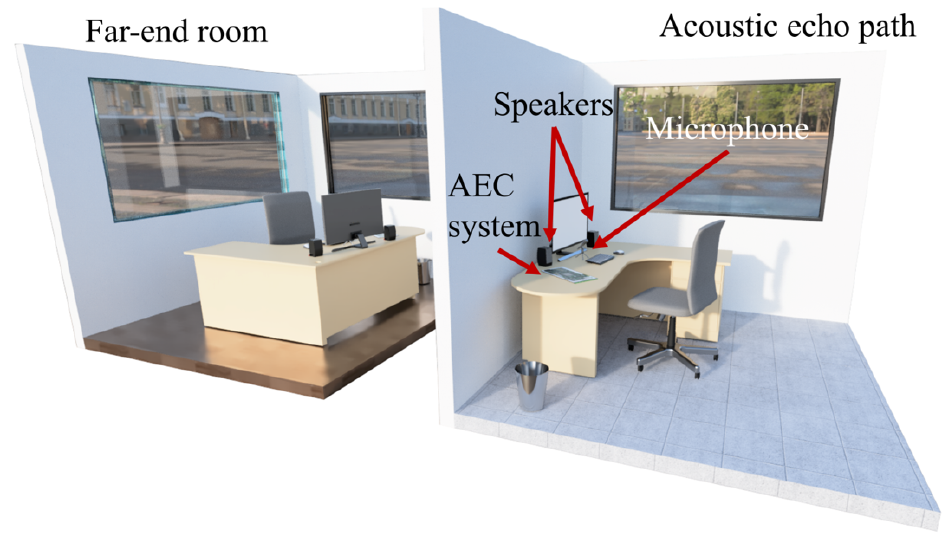
Figure 11. Scheme of the AEC